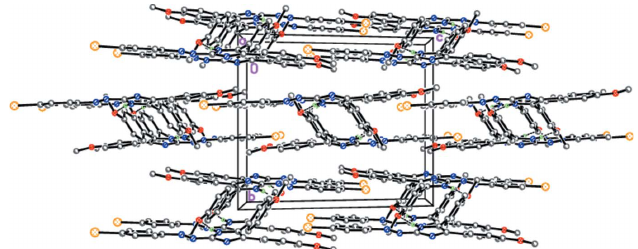
Figure 3 Crystal packing projected along the- a axis